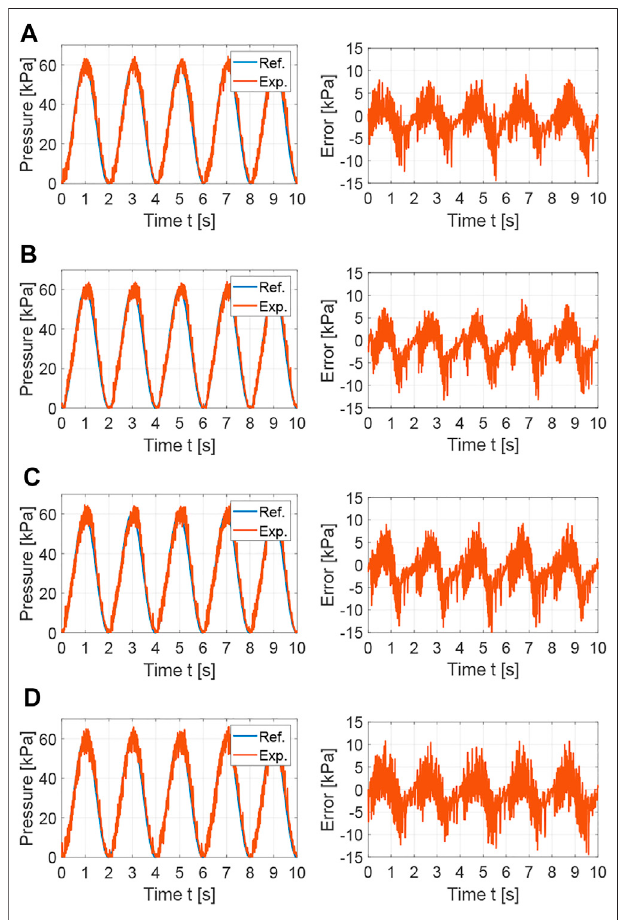
FIGURE 8 | Experimental results for the comparison of nonlinear control strategies: tracking performance and error for sine wave with T = 2 s. (A) SDREcontrol: Q (cid:1) 50and R (cid:1) 1. (B) Integralaugmentedslidingmodecontrol: k s (cid:1) 2, k i (cid:1) 0 . 01 and Φ (cid:1) 0 . 2. (C) Feedback linearization with integral action: k (cid:1) 40 and k i (cid:1) 0 . 01. (D) PI controller with feedforward and anti- windup: k p (cid:1) 10 and k i (cid:1) 0 .